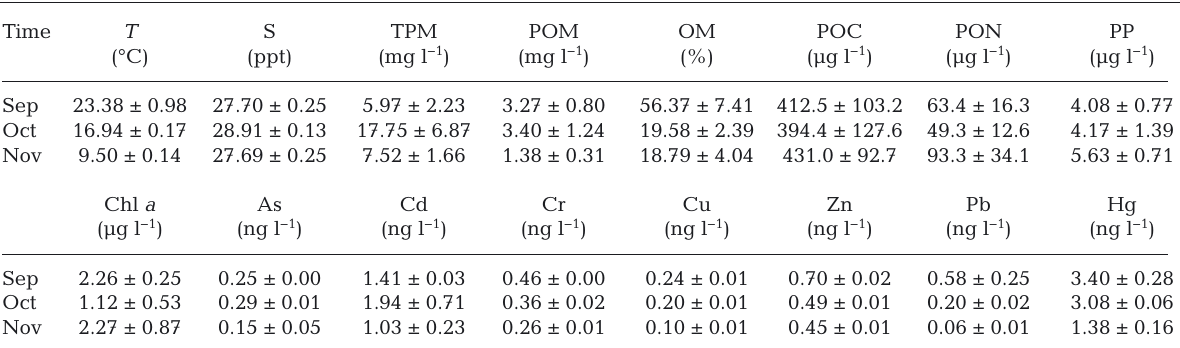
ferent treatments were analyzed using 1-way ana lysis of variance (ANOVA). Differences among different months were also analyzed using ANOVA. Prior to sta- tistical analysis, data were examined for normality of distribution and homogeneity of variance with Kol- mogorov-Smirnov test and Levene’s test, respectively. A statistical significance level of 0.05 was used. Statis- tical analyses were carried out using the software R v.1.0 for Windows (R Development Core Team 2016). Table 1. Mean (±SD) monthly variations of environmental factors and concentrations of particulate material and trace elements of surface waters at the experimental site in Laizhou Bay. T : temperature; S: salinity; TPM: total particulate matter; POM: particulate organic matter; OM: organic matter; POC: particulate organic carbon; PON: particulate organic nitrogen; PP: particulate phosphorus; Chl a : chlorophyll